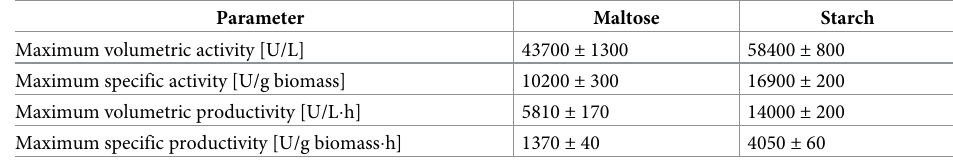
Table 1. Kinetic parameters of α -amylase production by C . wangnamkhiaoensis in steady-state continuous cultures.